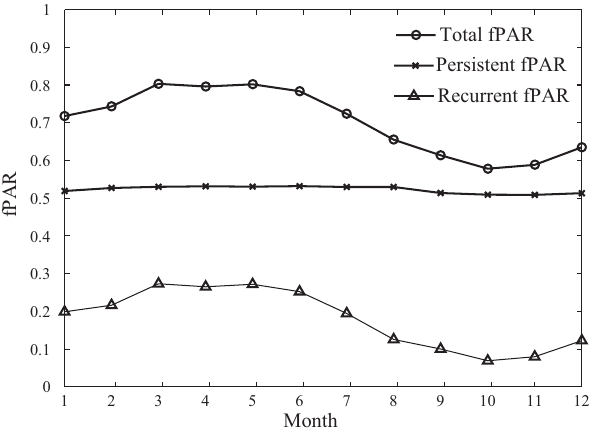
Fig. 2. An example (catchment code: 110003) of mean monthly fPAR based on separating total fPAR ( F t ) into recurrent fPAR ( F r ) and persistent fPAR ( F p ) from the 26-year